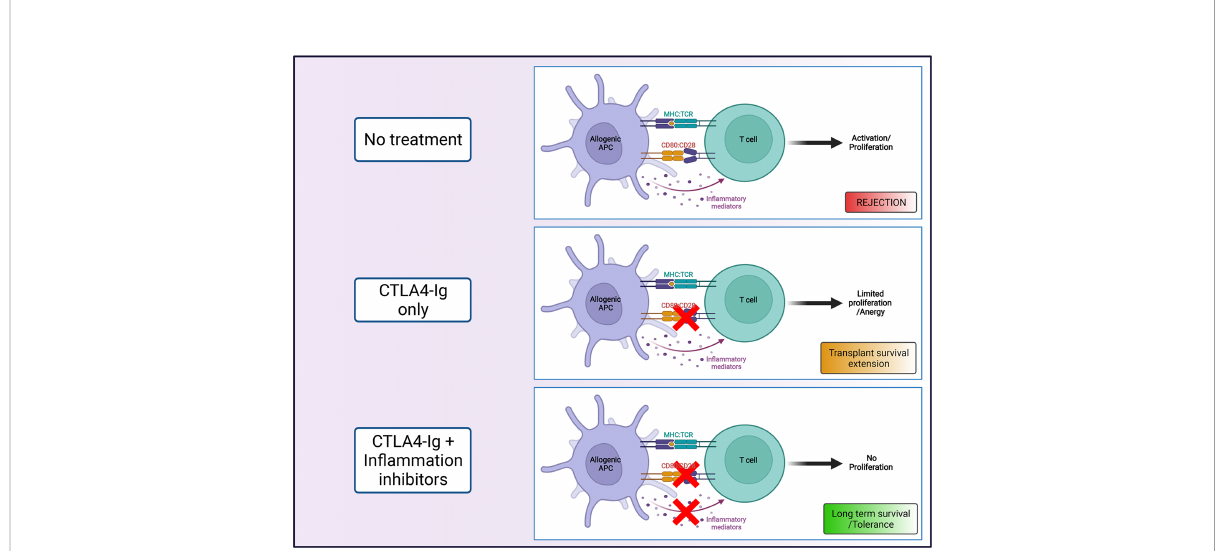
FIGURE 1 Costimulation blockade as strategy to promote transplant survival. The combination of CTLA4-Ig, that blocks interactions between CD28 and CD80/86 (signal 2), with agents that limit the contribution of in fl ammatory mediators (signal 3) on T cell activation, can promote long term transplant survival (Created with